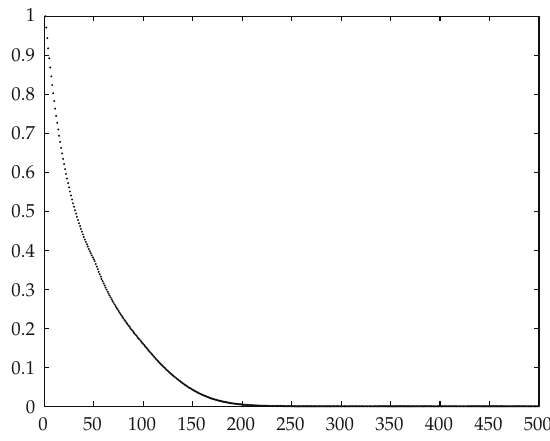
Figure 3: One-leg θ -method with θ (cid:6) 1 / 2 for (cid:4) 5.2 (cid:5) .